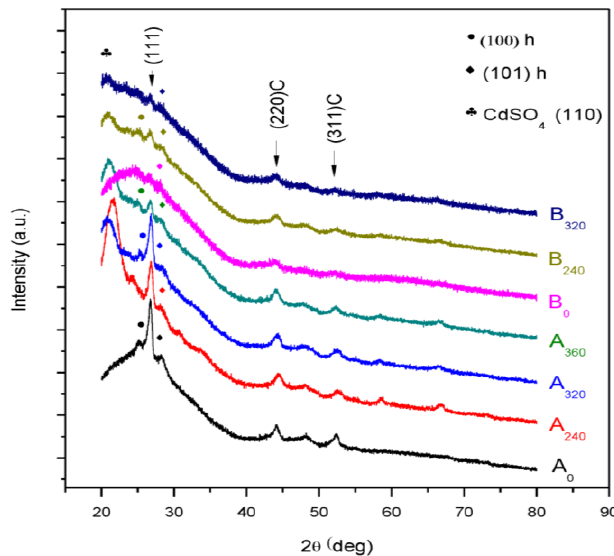
Figure 1. XRD pattern of CdS film for different annealing temperatures.